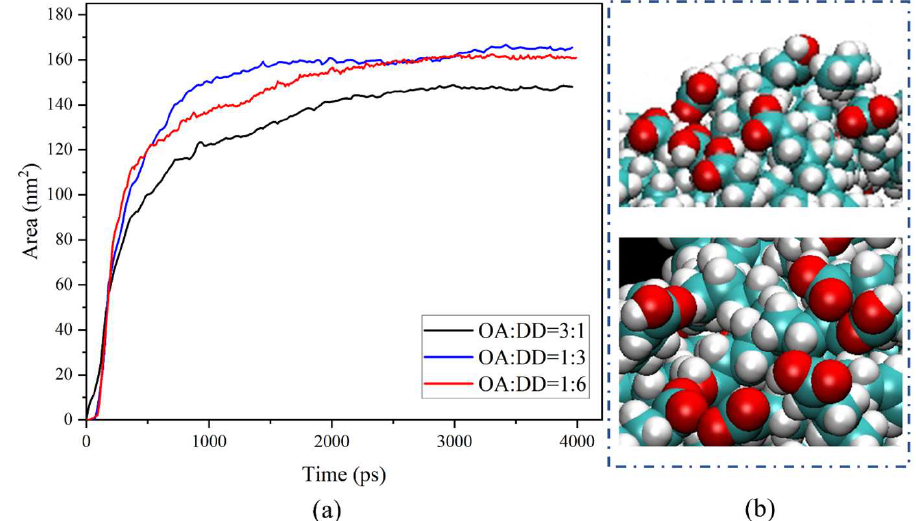
Figure 7. ( a ) Spreading area variation curves of the compound collectors with three proportions. ( b ) Self-aggregation of some OA molecules. Red atoms are oxygen atoms, green atoms are carbon atoms, and white atoms are hydrogen atoms.